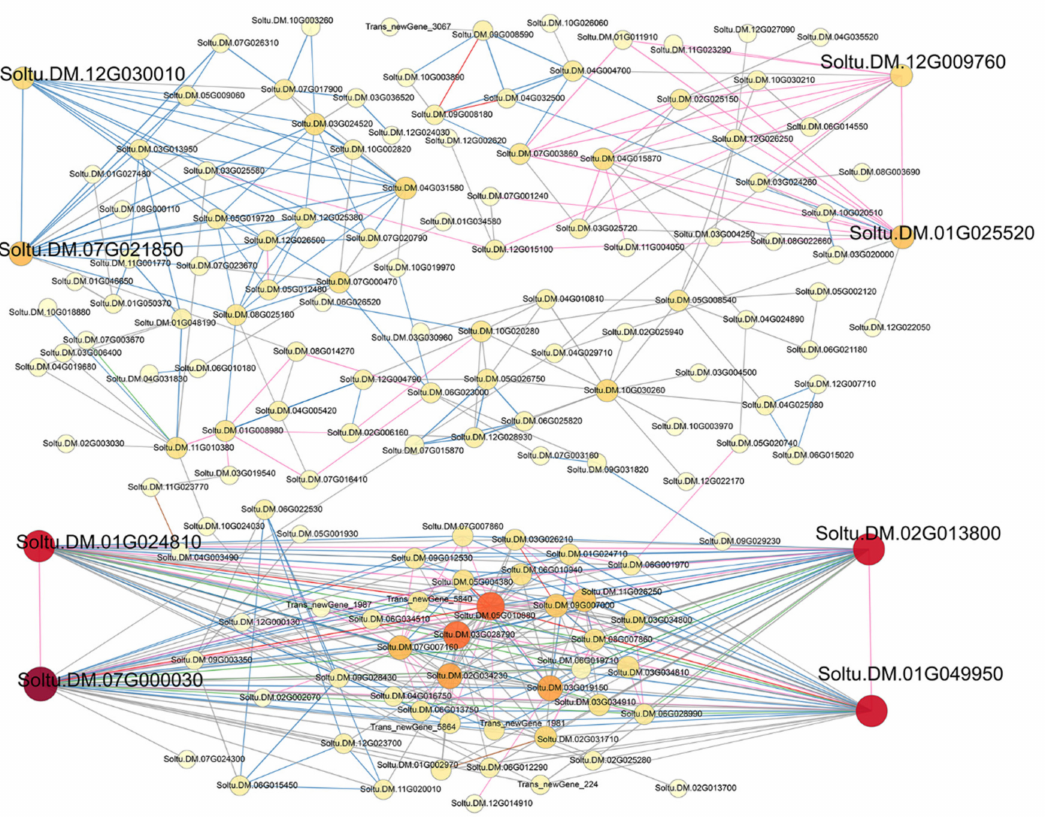
Figure 9. A PPI network of DEGs from variety A versus Q under dual treatment for 12